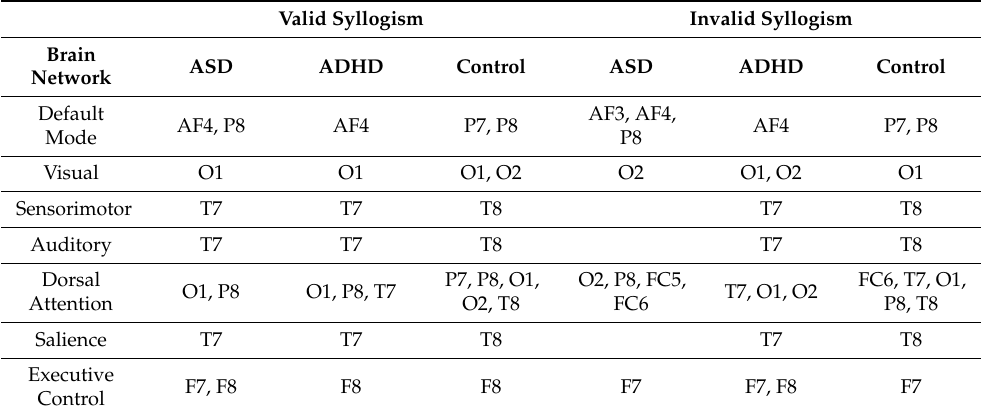
Table 12. Linking major brain systems’ regions [144] to activated regions (channels) of the present